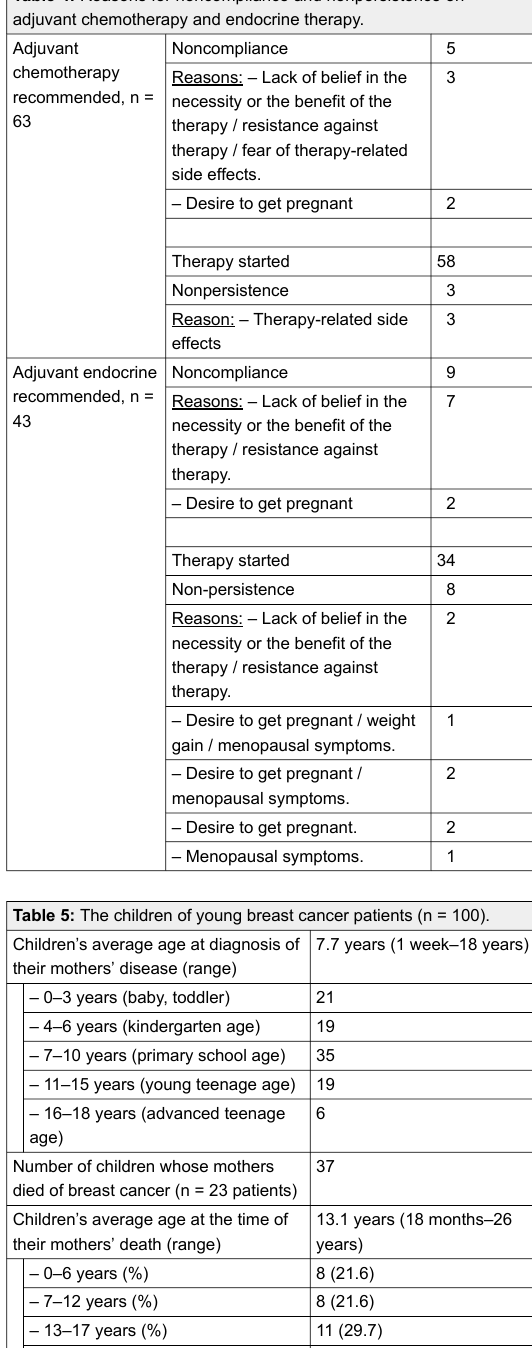
Table 4: Reasons for noncompliance and nonpersistence on adjuvant chemotherapy and endocrine therapy. Noncompliance